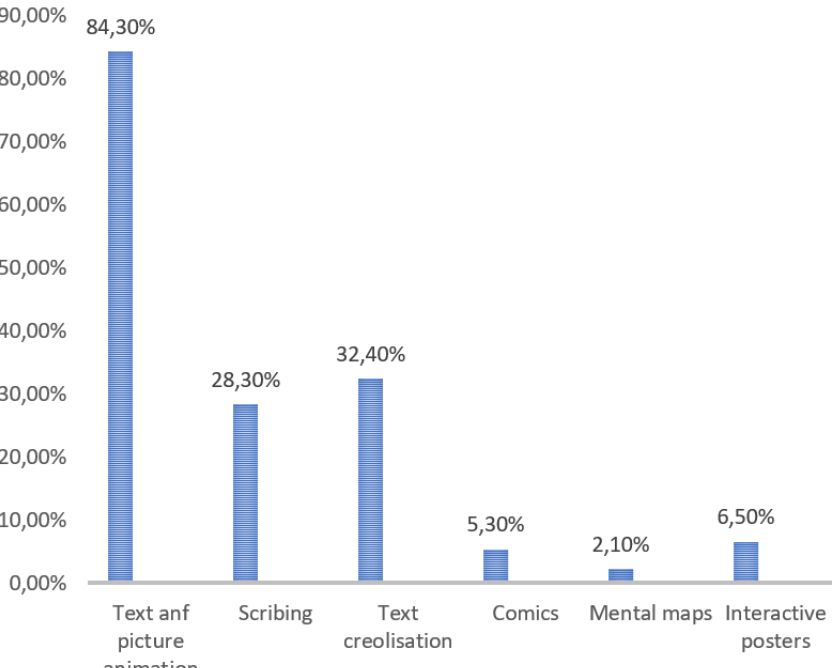
Figure 4: The use of ICT technologies in multimedia presentations of future primary education profes-